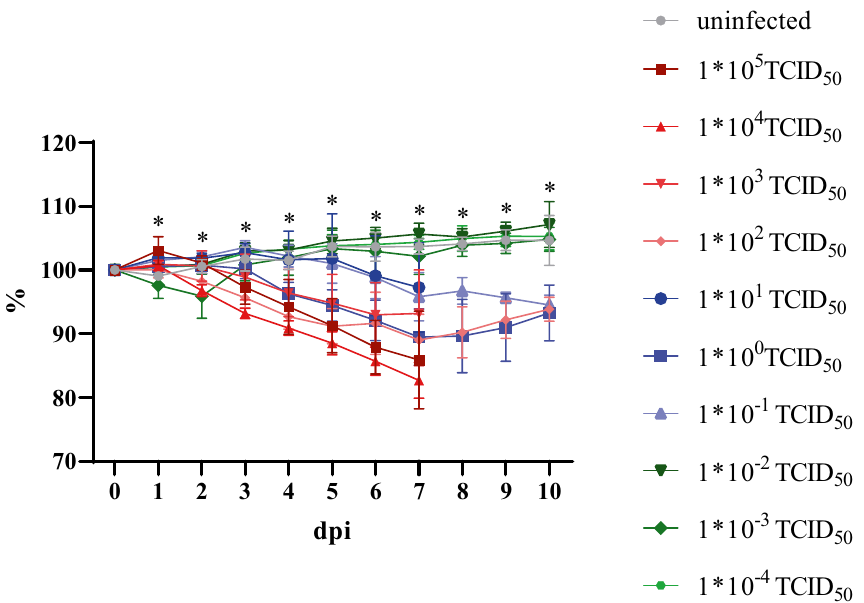
Figure 2. Cumulative mean and standard deviation of three experiments of body weight per infection dose groups. Changes in body weight (%) in relation to 0 dpi. Statistically significant differences in daily body weight changes are marked by an asterisk. P = 0.0001 for all days. Further details on statistical analysis are shown in Table